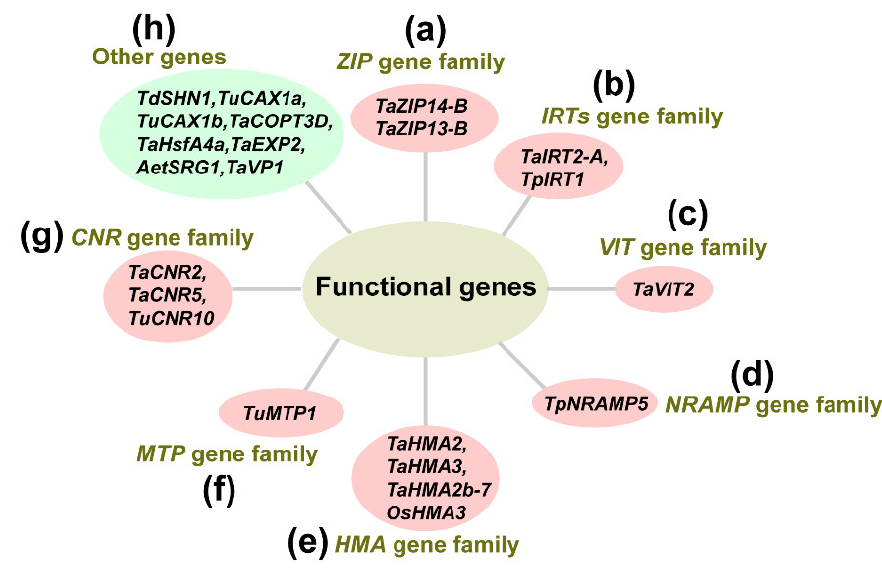
Figure 3. Functional genes that regulate heavy metal stress in wheat.